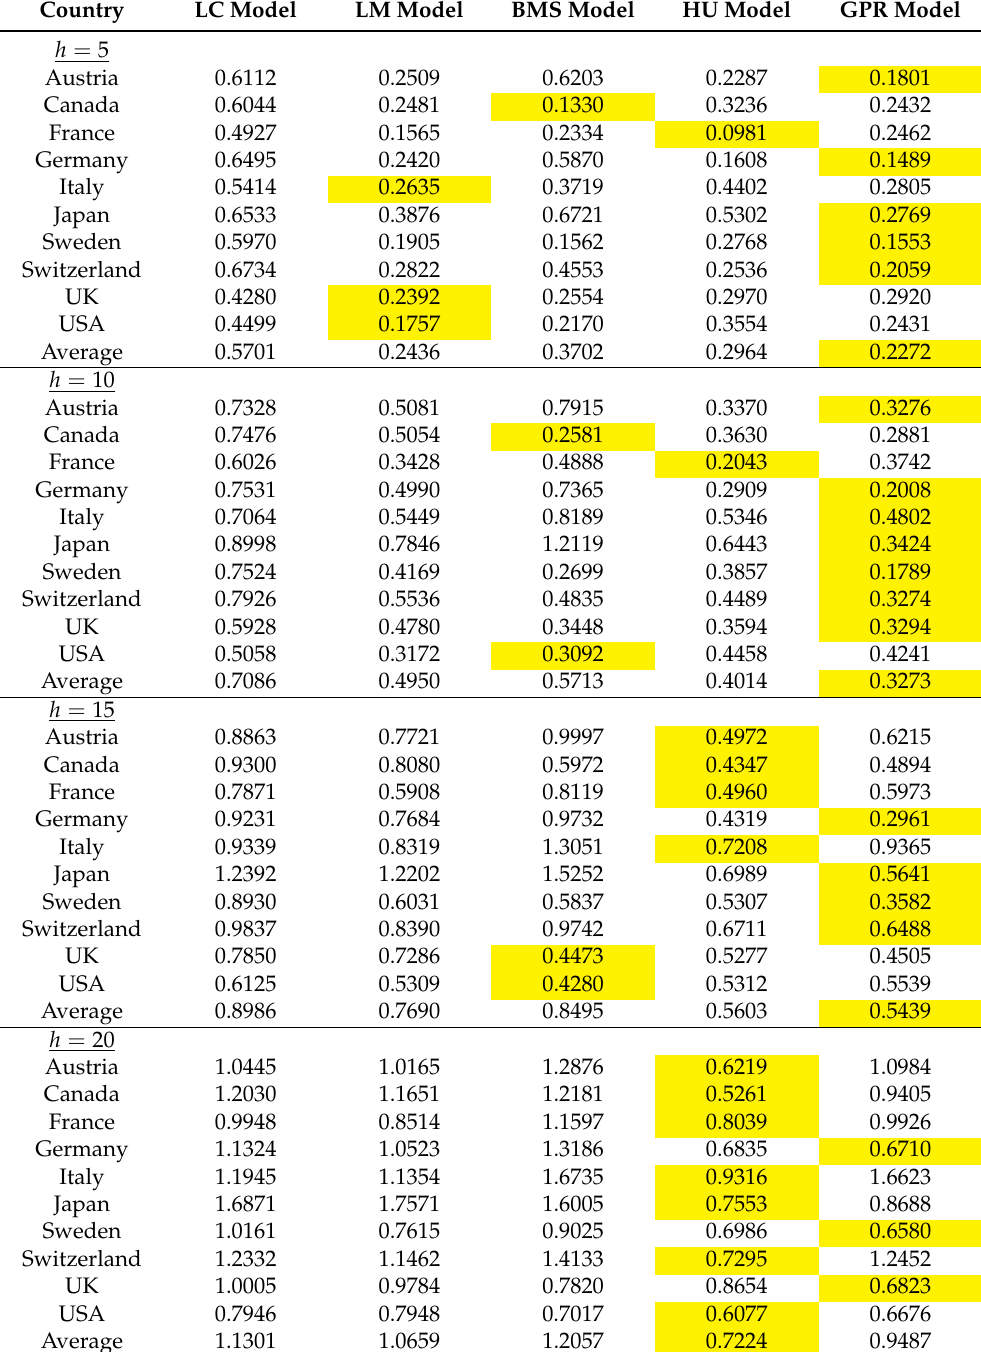
Table 2. The average RMSEs of ten sets of rolling-window analysis on the predicted fertility curves using the LC model, the LM model, the BMS model, the HU model and the GPR model. The lowest forecast errors among all the models are